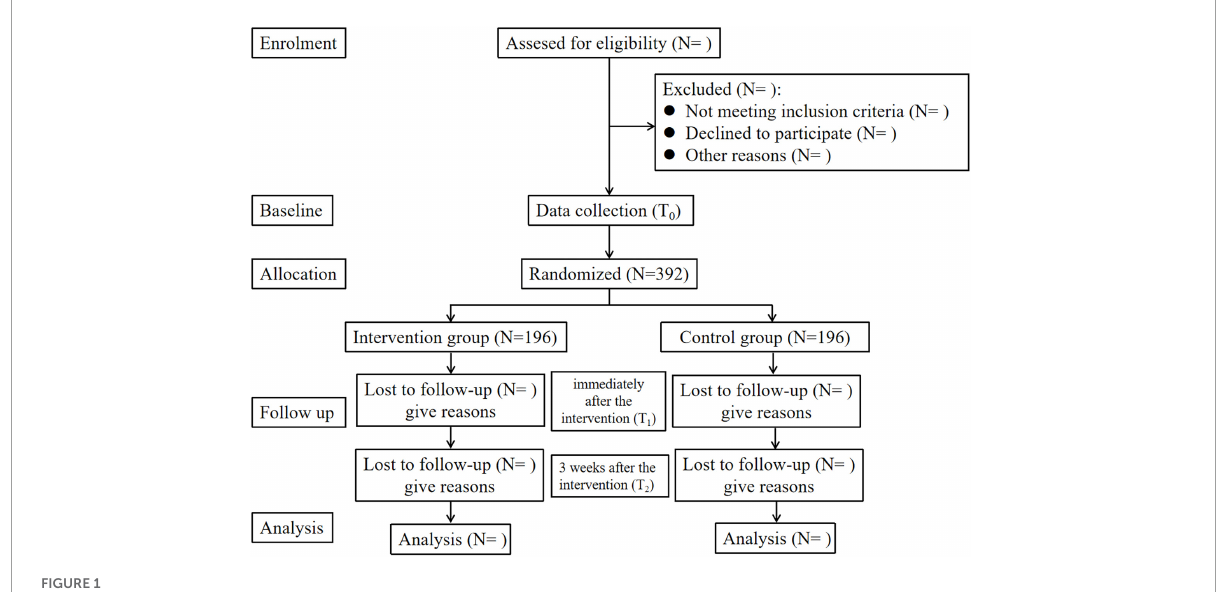
FIGURE1 An overview of the study